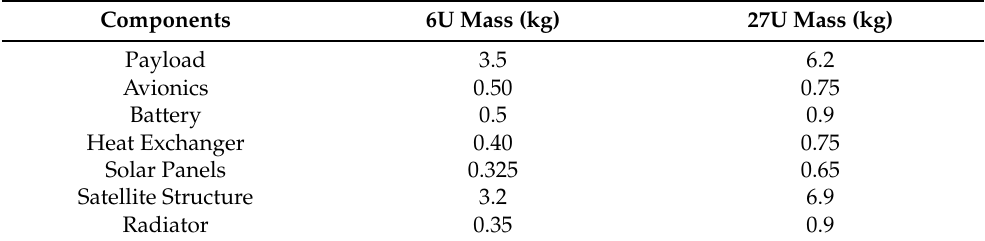
Table 4. Mass distribution—6U